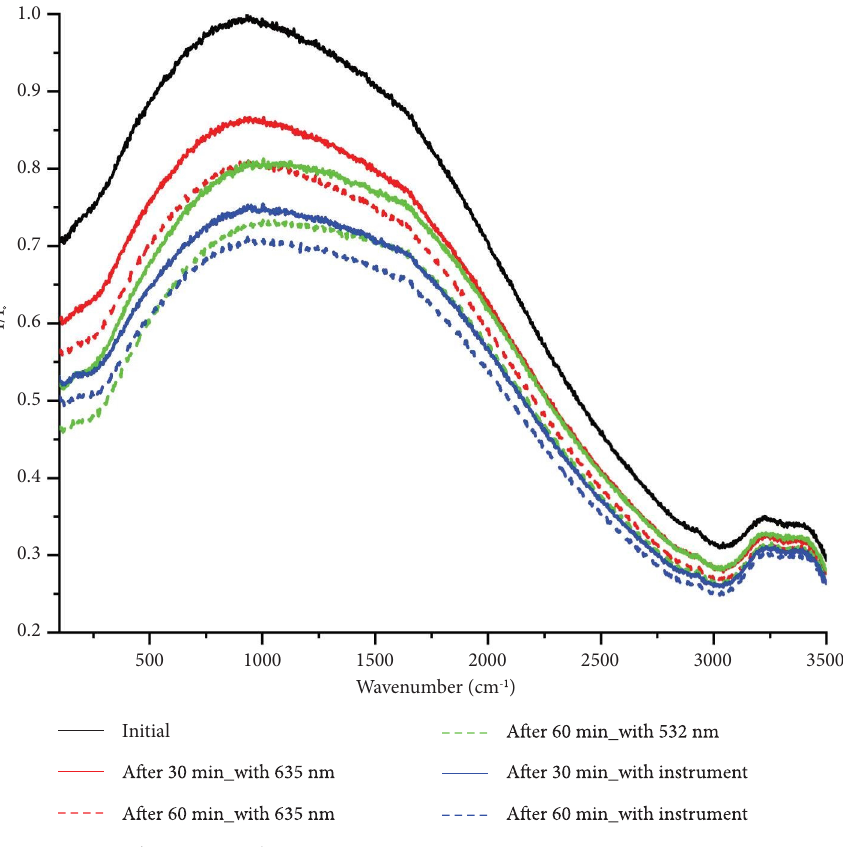
Figure 6: Initial spectrum of BSA and after 30 and 60min of exposure to external 635nm laser and 532nm laser and to 633nm Termo Fisher Raman spectrometer laser. All the spectra were measured with 1s exposure and accumulated 10 times. Te spectra were expressed relative to the initial